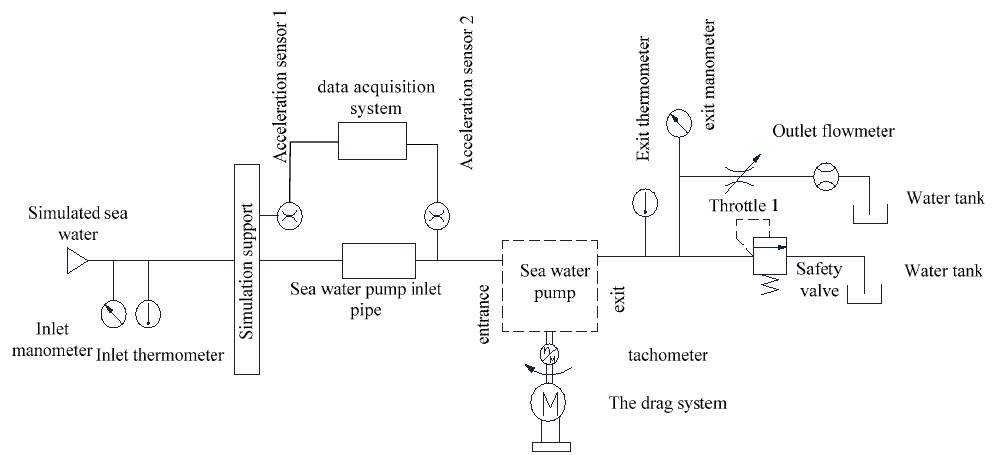
Figure 6. Schematic diagram of the test system.